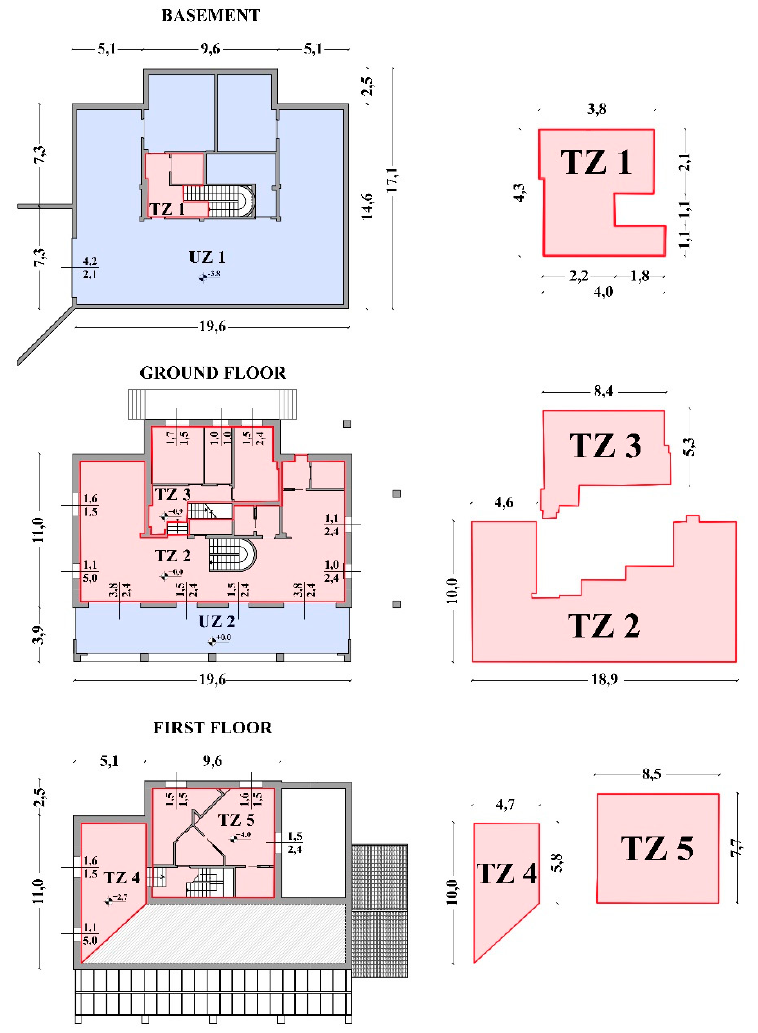
Figure 3. Heated thermal zones (TZ) (in red) and unheated zones (UZ) (in blue) (left: external opaque wall dimensions and windows; right: internal dimensions of the thermal zones).